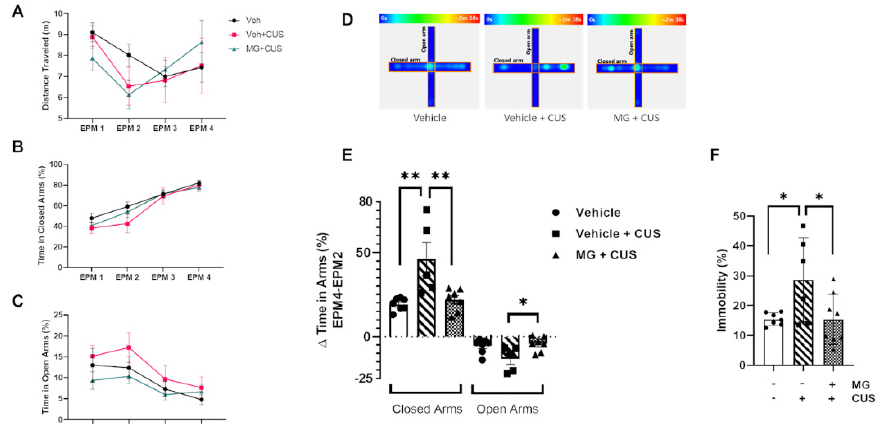
Figure 6. EPM trends are shown for distance traveled (m) ( A ), time in closed arms (%) ( B ), and time in open arms ( C ) throughout the experiment. No significant differences were observed. All graphs represent mean ± s.e.m. Heat map representing the time spent in closed and open arms in the Y-maze ( D ). Difference between the two time points after and before CUS: EPM4-EPM2 ( E ). Forced swim test (FST) ( F ), as indicator of depressive-related behavior, in the presence (+) and absence ( − ) of MG (10 µ M) treatment, and in the presence (+) and absence ( − ) of CUS. All graphs represent mean ± s.e.m. Significance levels, as calculated by one-way analysis of variance, are indicated as: ( E ) for ■ ■ ■ ● vs. ** p = 0.037; vs. ▲ ** p = 0.0082; for open arms: vs. ▲ * p = 0.0353; ( F ) closed arms: ■ ▪ ● vs. * p = 0.0463; vs. ▲ * p = 0.0378.